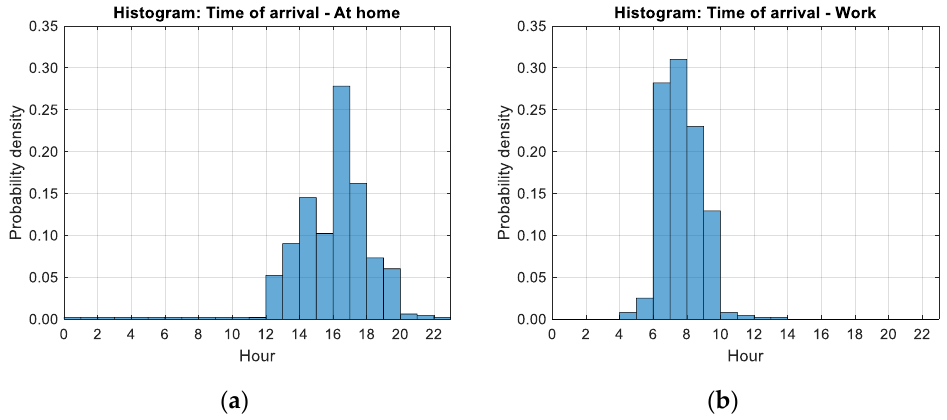
Figure A2. Probability density of the time of arrival at home ( a ) and at work ( b ) [65].